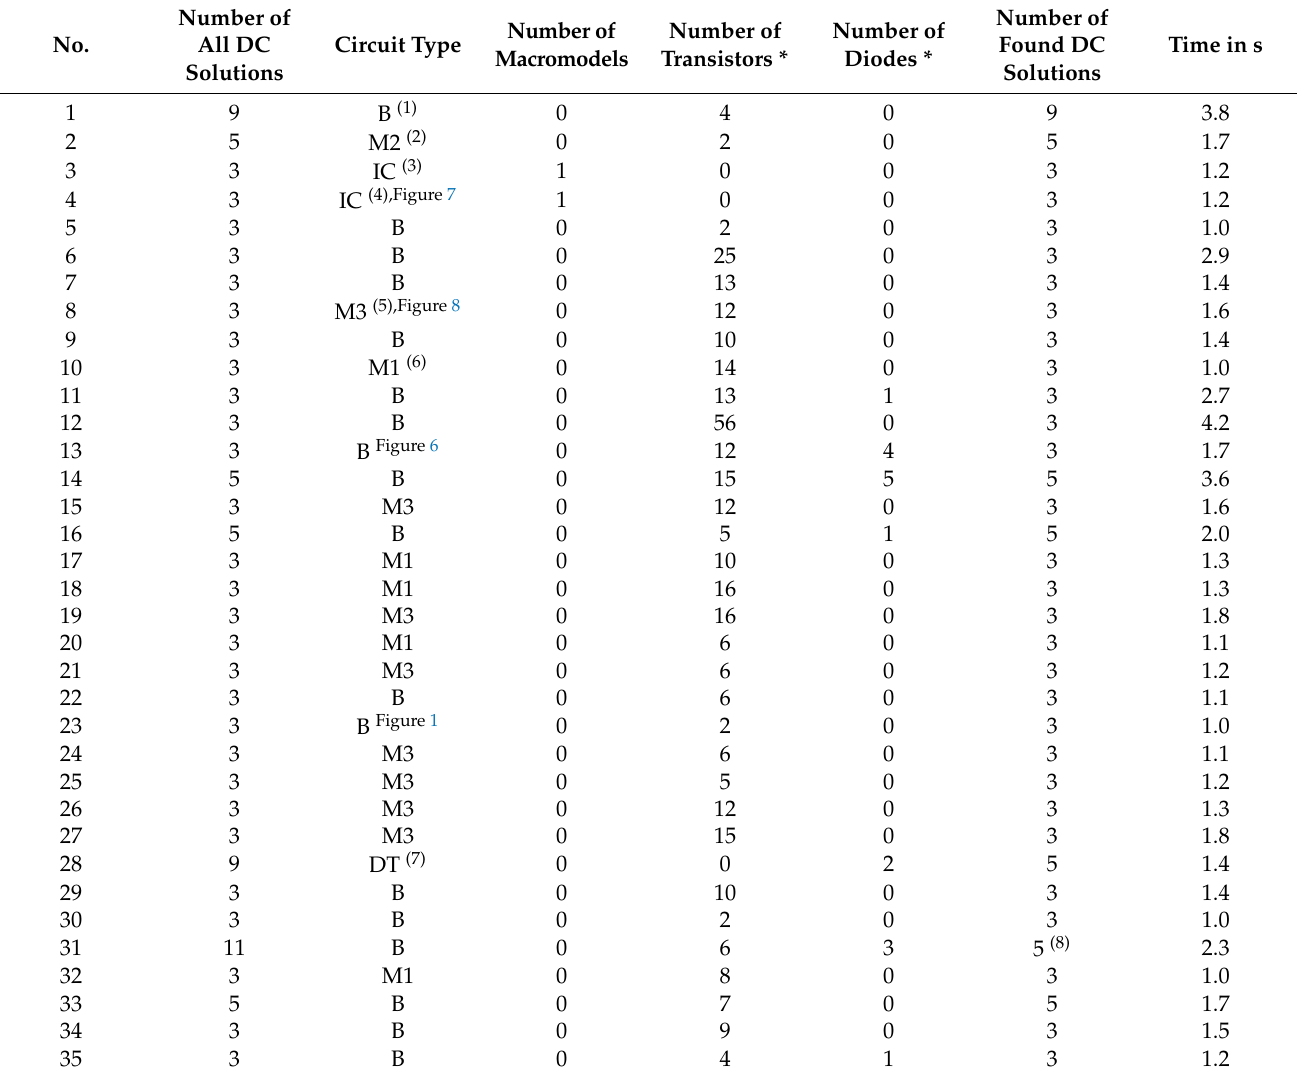
Table 1. Key parameters and results of calculations for exemplary circuits with multiple DC